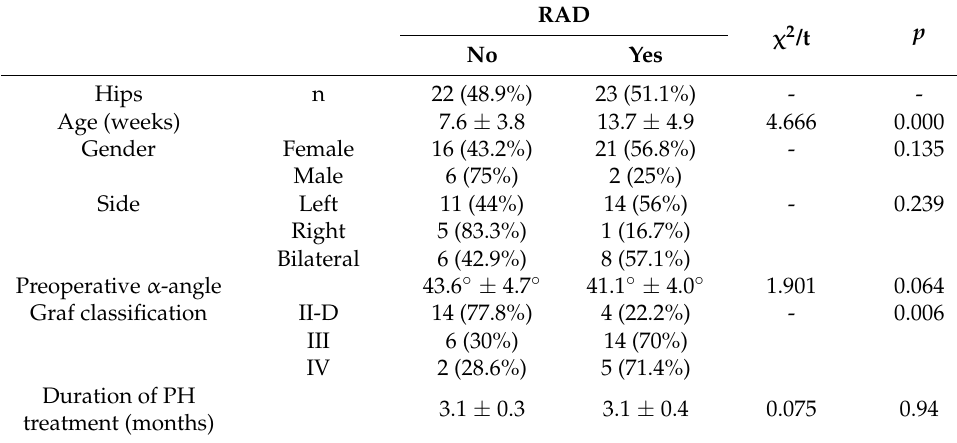
Table 2. Comparison of clinical data between patients with and without RAD six months after the completion of PH